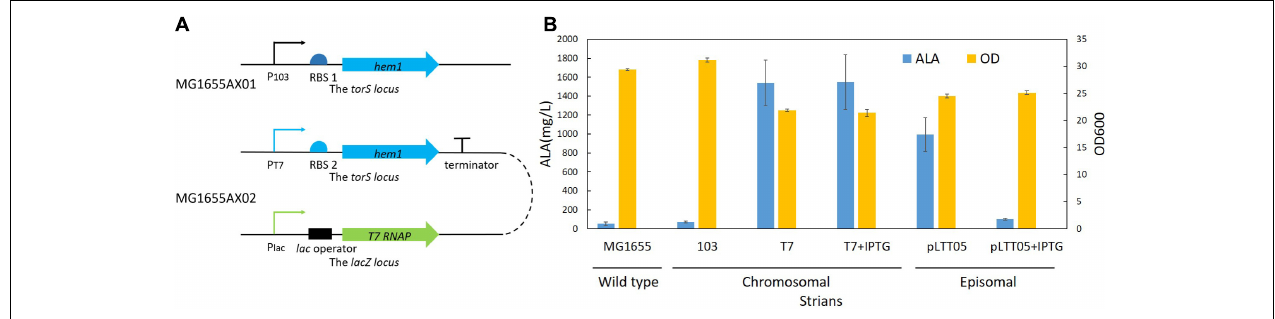
FIGURE 7 | ALA production by different strains. (A) A schematic of the genetically modified MG1655 strains. (B) Results of ALA production. 103 stands for the strain MG1655AX01 which carries a chromosomally integrated hem1 gene controlled by the 103 promoter; T7 stands for the strain MG1655AX02 which carries a chromosomally integrated hem1 gene controlled by the T7 promoter and a chromosomally integrated T7 RNA polymerase gene controlled by the native lac promoter; pLTT05 stands for the strain MG1655AX03 which harbors the plasmid pLTT05. pT7 + IPTG and pLTT05 + IPTG denote that IPTG was added during the fermentation of the corresponding